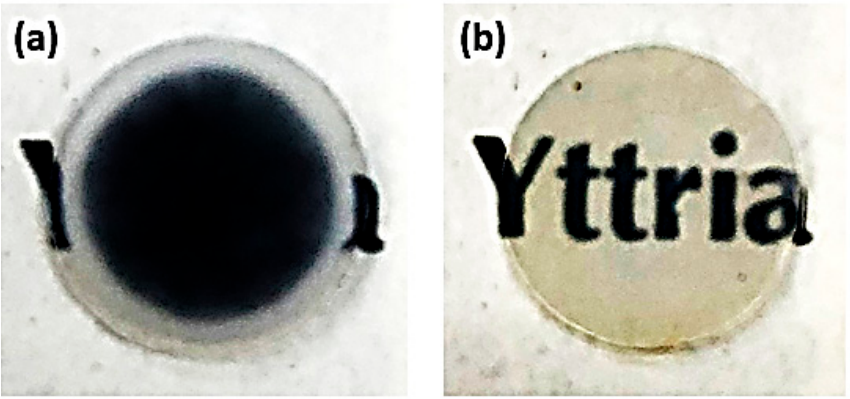
Figure 3. The photos of the sintered monolithic Y 2 O 3 ceramics fabricated from ( a ) as-received and ( b ) ball milled nanopowders, respectively.